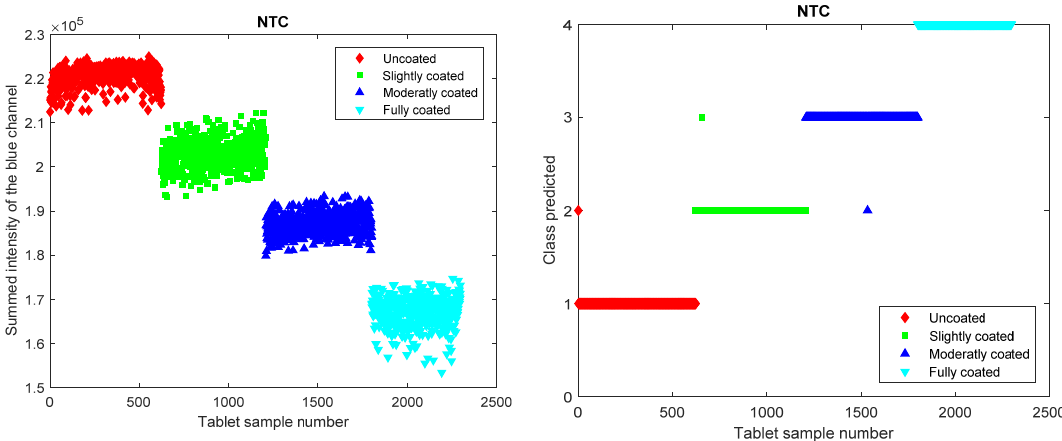
Figure 4. Spatially summed blue channel pixel intensities of all the single tablet images ( left ). Numerical threshold classification method showing predicted class versus tablet sample number ( right ).